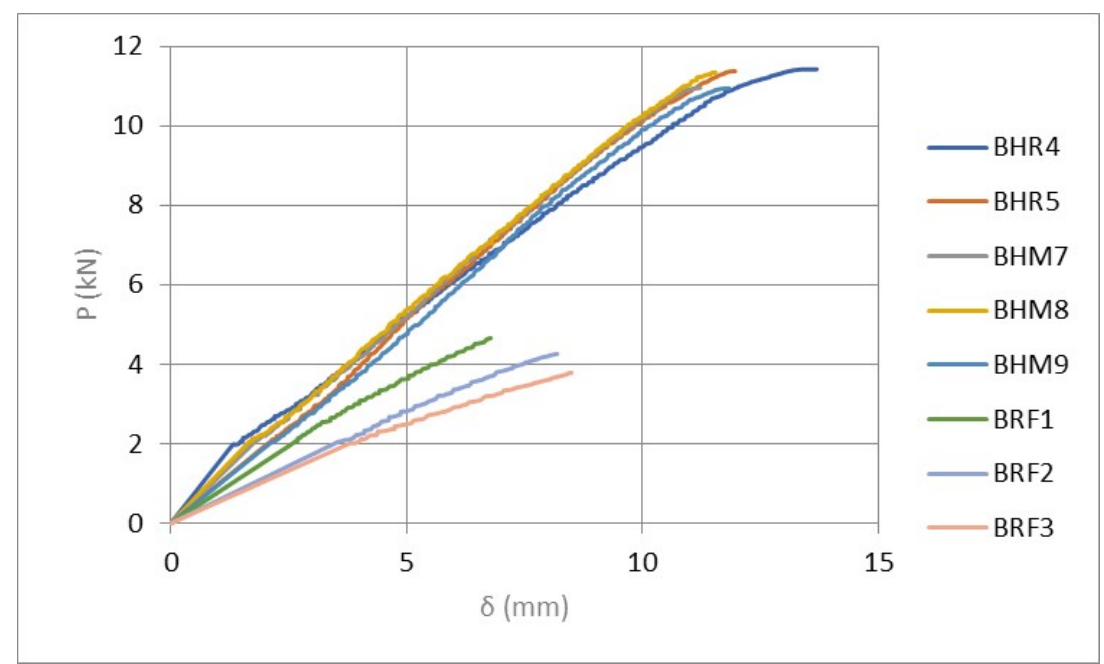
Figure 4. Load–displacement graph for the beams tested.